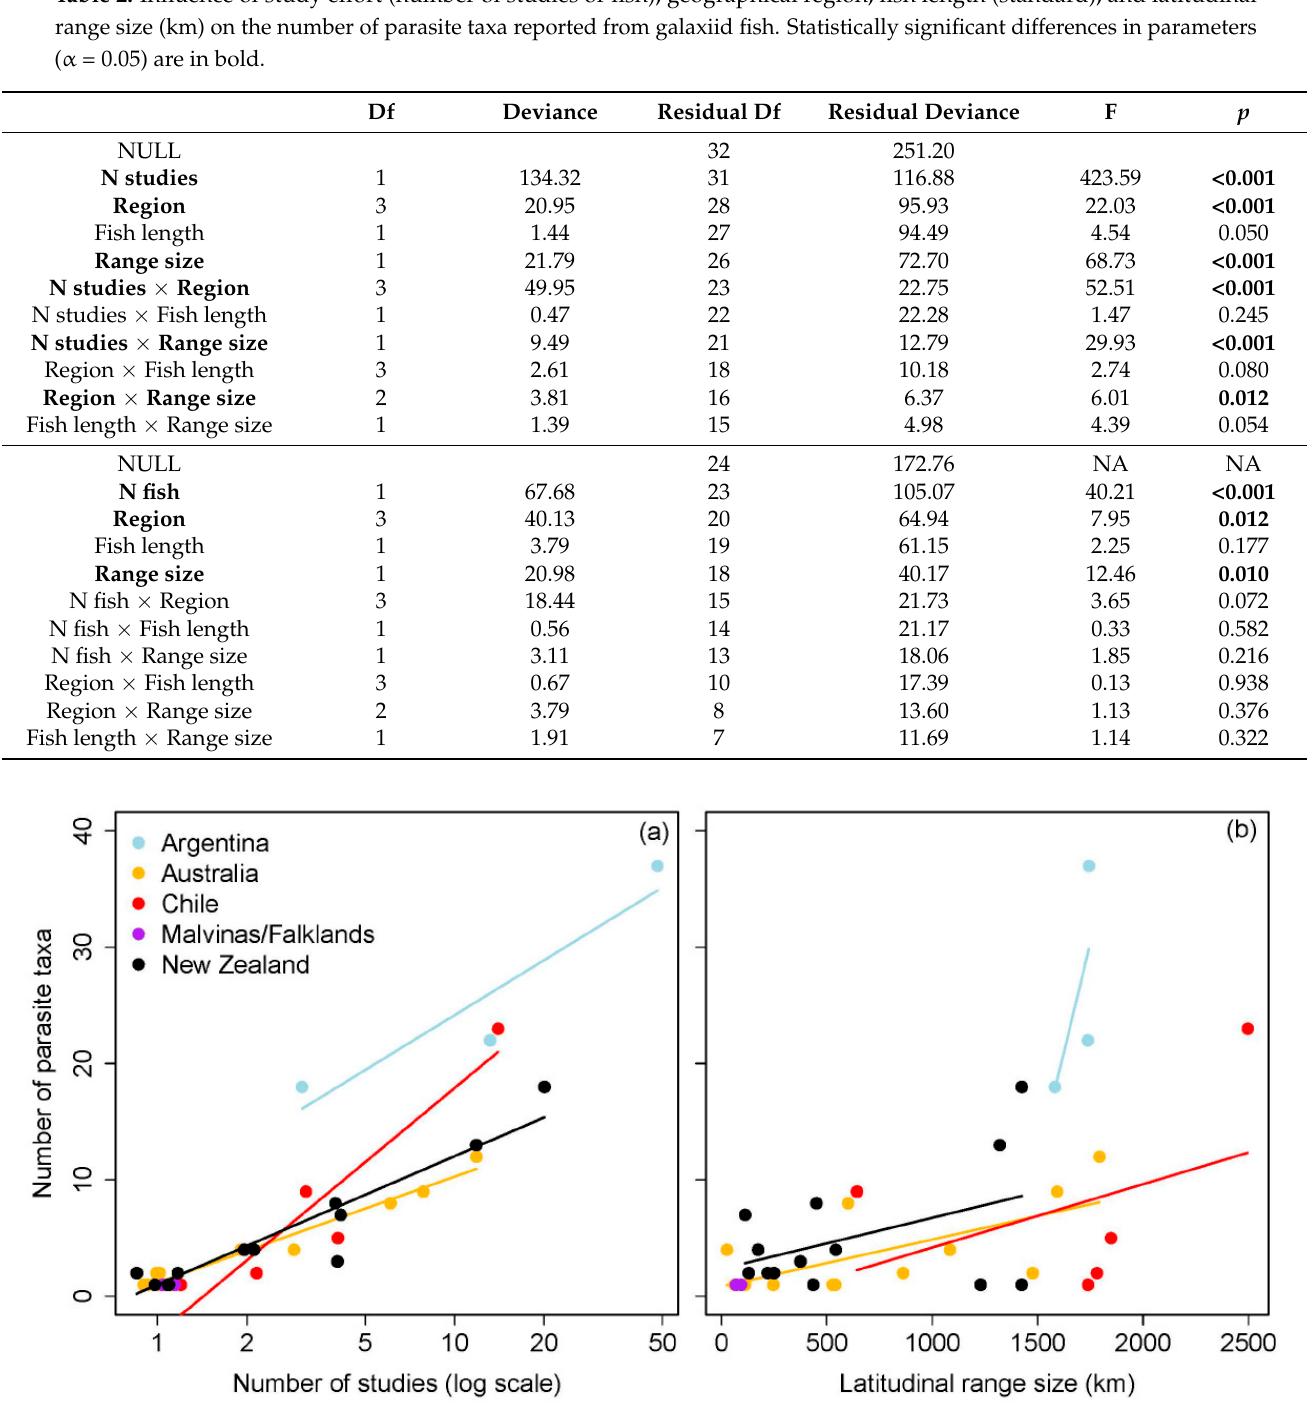
Figure 2. Influence of latitudinal range size (km) and the number of studies on the predicted num- ber of parasite taxa reported in galaxiid fishes. The number of fish examined was reported from 66.4% of studies ( n = 40 Argentina, 18 Australia, 16 Chile, 2 Malvinas/Falklands, 19 New Zealand). The number of parasite taxa was positively correlated with both the number of fish examined and latitudinal range size (Table 2, Figure 3) and also differed between geographic regions, with signifi- cantly more parasite taxa reported in Argentina than other geographic regions (Tukey HSD post hoc test: all p < 0.05). Standard length did not influence the number of parasite taxa per host species among studies where the number of fish examined was reported.